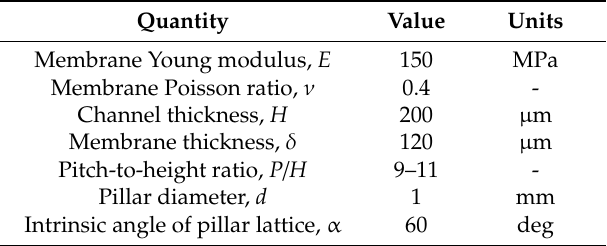
Figure 2. Computational domain: A detailed image of the Finite Element computational mesh is also shown. Table 1. Geometrical and mechanical quantities (both sides).